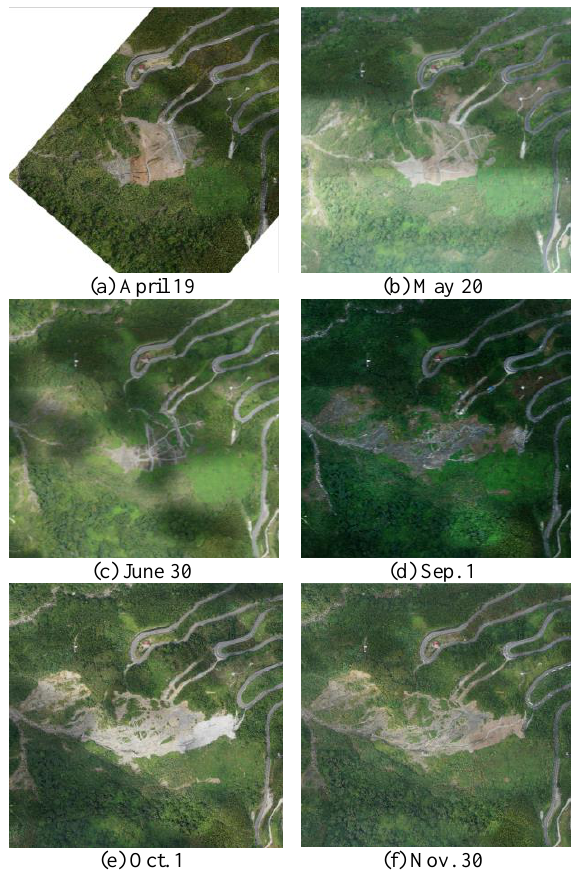
Figure 12.Ortho-image of each date.